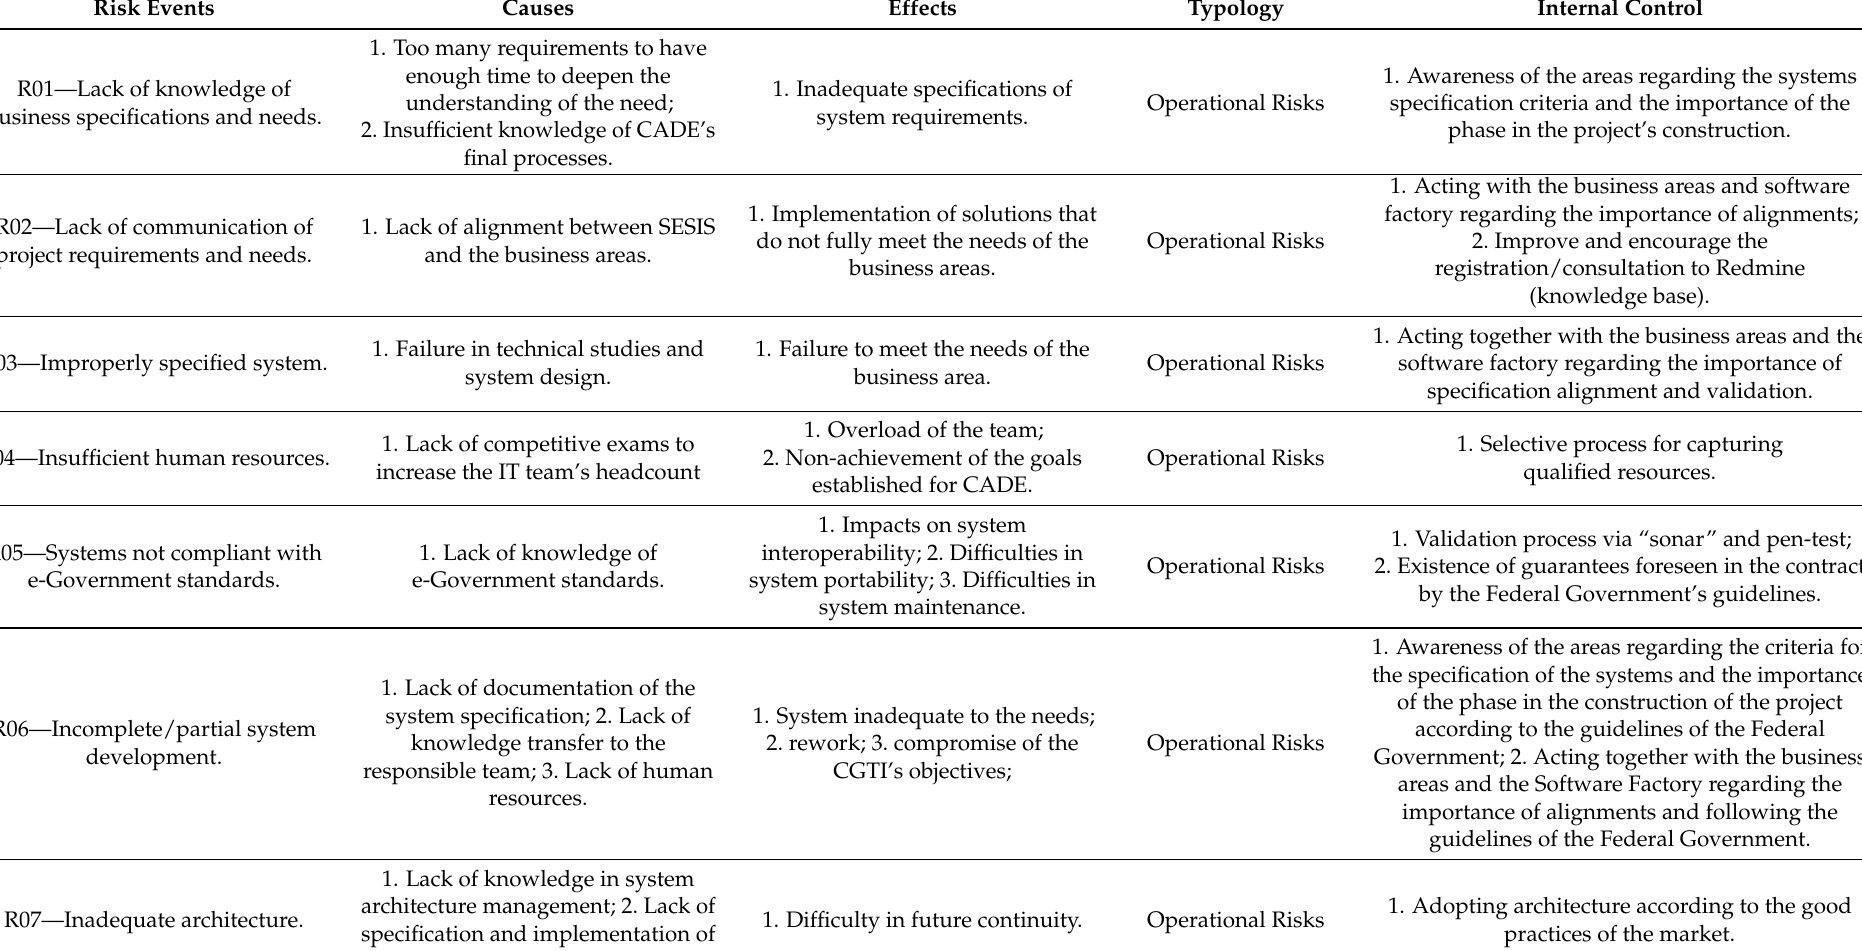
Table 4. Identified Risk Events in the Manage Information System